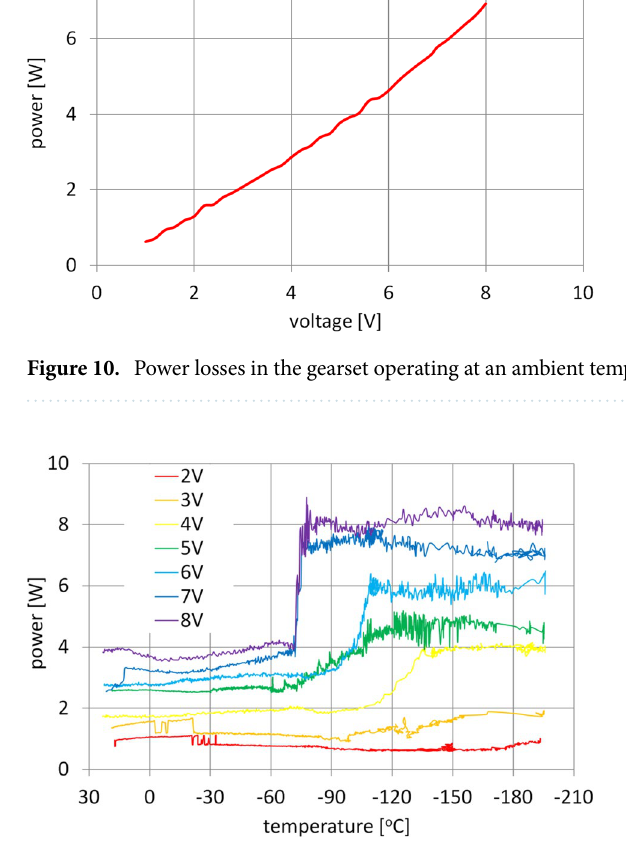
Figure 11. Measurements of the motor power